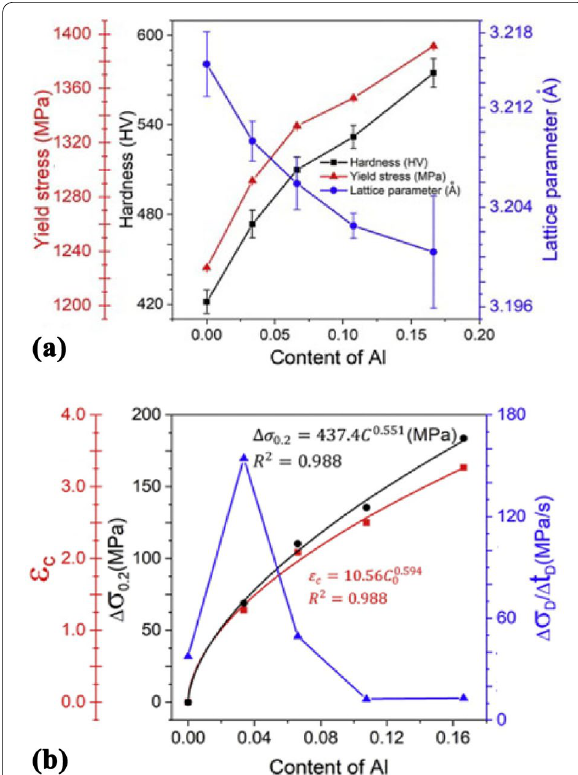
Figure 3 ( a ) The variation of yield strength and hardness with lattice parameter, ( b ) the variation of critical strain, change of stress and stress drop rate with content of Al [33]